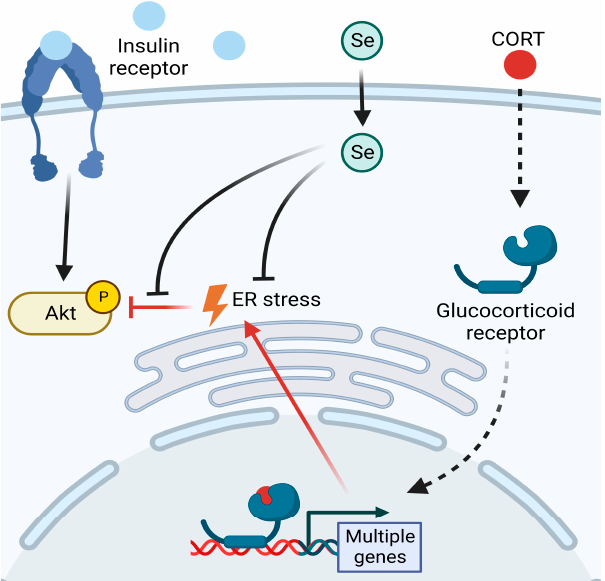
Figure 4. Proposed model of the ability of selenium to protect insulin signaling from being impaired by chronic corticosterone exposure in mHypoE-44 hypothalamic cells. Upon binding insulin, the insulin receptor initiates an intracellular signaling cascade that involves the activation (via phosphorylation) of protein kinase B (AKT). Endoplasmic reticulum (ER) stress limits the phosphorylation of AKT, an effect that is exacerbated by chronic exposure to corticosterone (CORT). Supplementation with additional selenium (Se) is able to prevent CORT from exacerbating ER stress and, subsequently, inhibiting insulin signaling. Red lines highlight the pathological effects of chronic CORT.